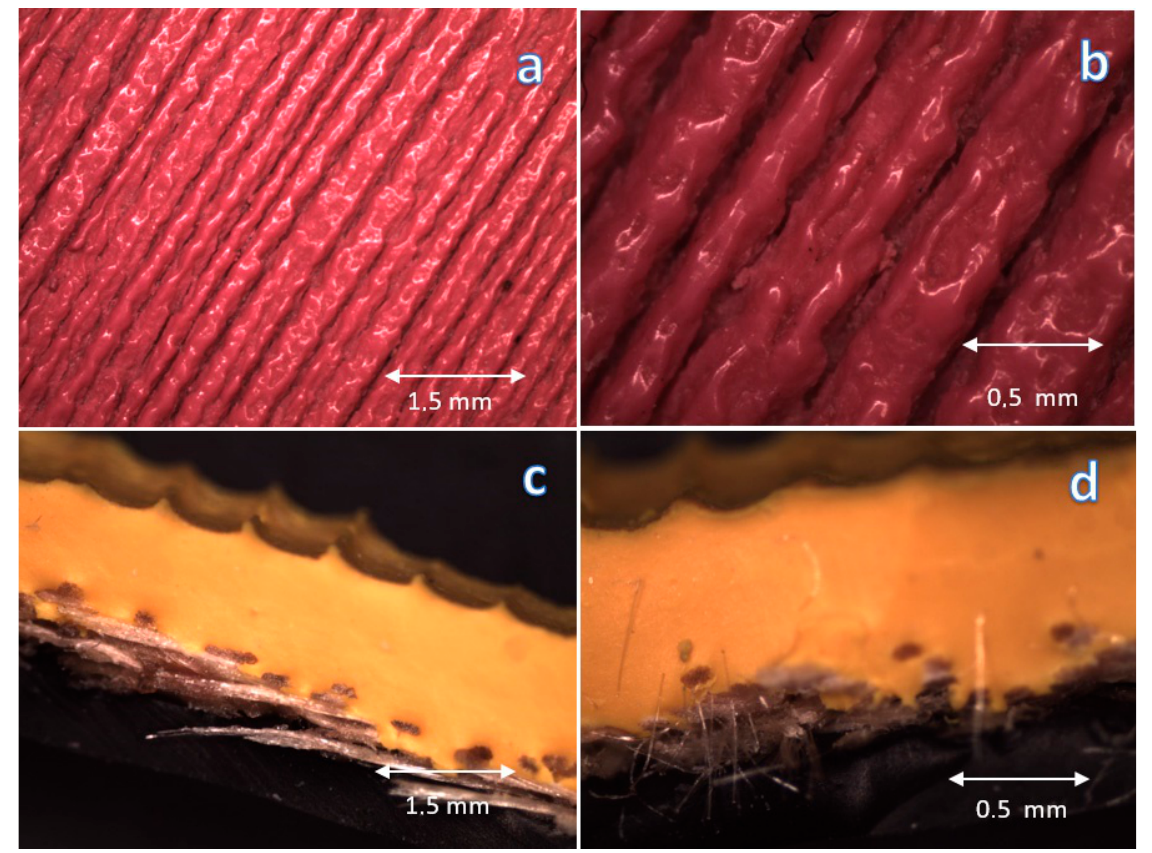
Figure 7. Photos of Mikasa ball: surface ( a ) 10×, ( b ) 30×, cross-section photos ( c ) 10×, ( d ) 30×.